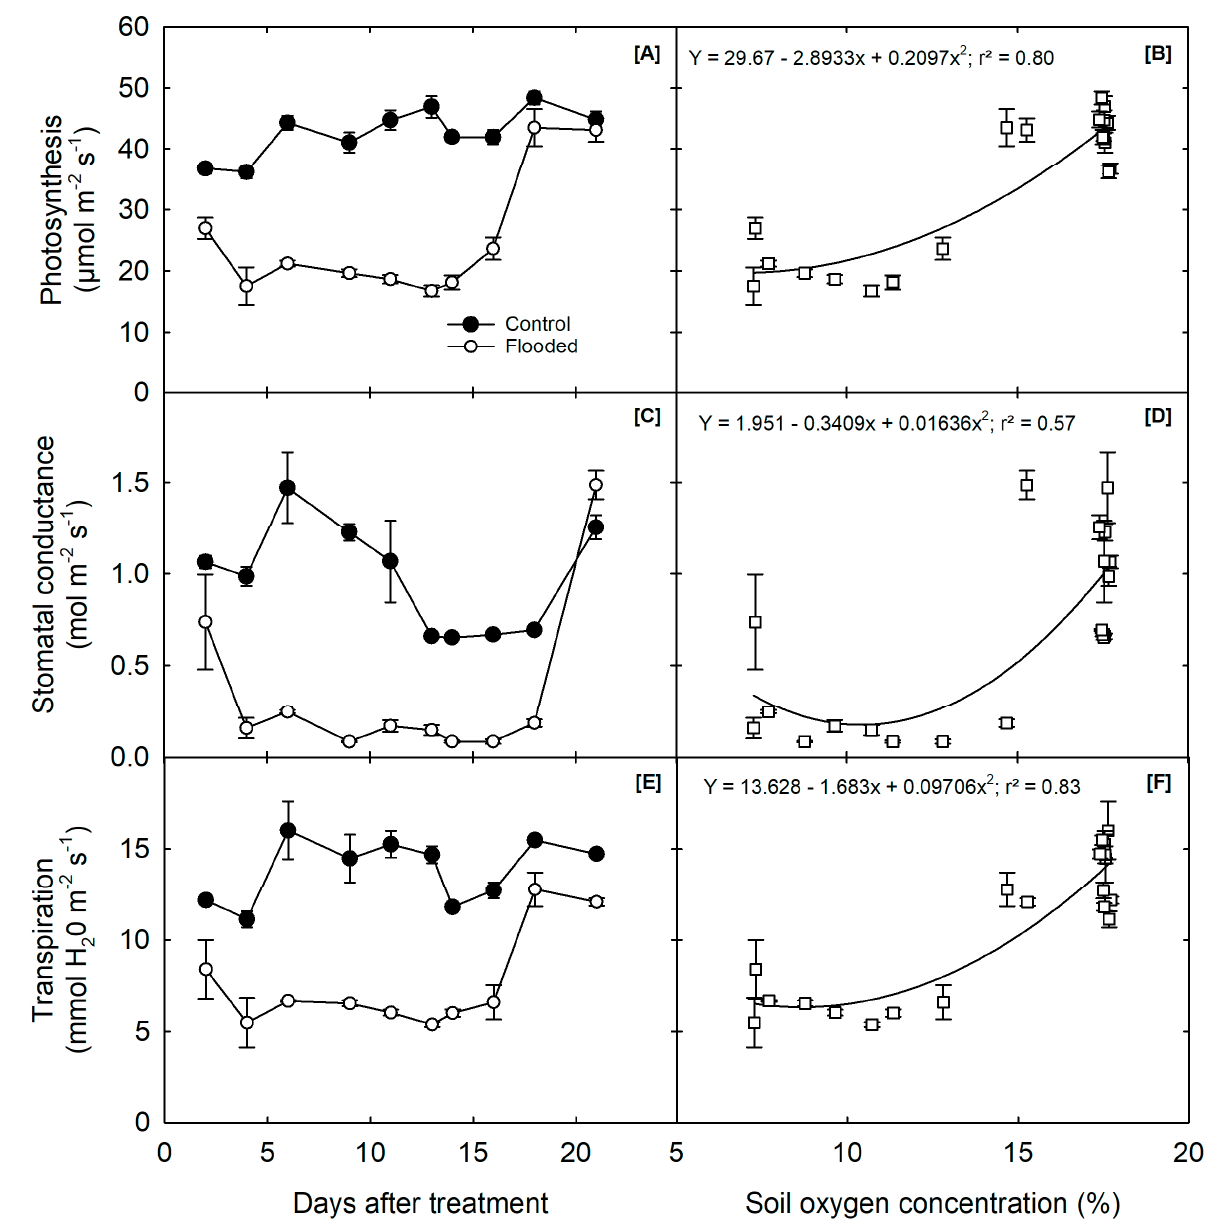
Figure 2. Influence of waterlogging on soybean plants: ( A ) net photosynthetic rate (P n ), ( C ) stomatal conductance (g s ), and ( E ) transpiration rate measured during the waterlogging treatment and ( B ) photosynthesis, ( D ) stomatal conductance, and ( F ) transpiration expressed as a function of soil oxygen concentration (%) using both the treatments data. The graph shows the day that waterlogging treatment stopped, and the recovery period started, at 16 days.